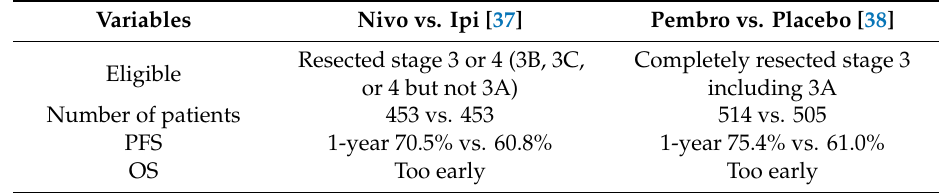
Table 6. Anti-PD-1 adjuvant therapy for resected high-risk